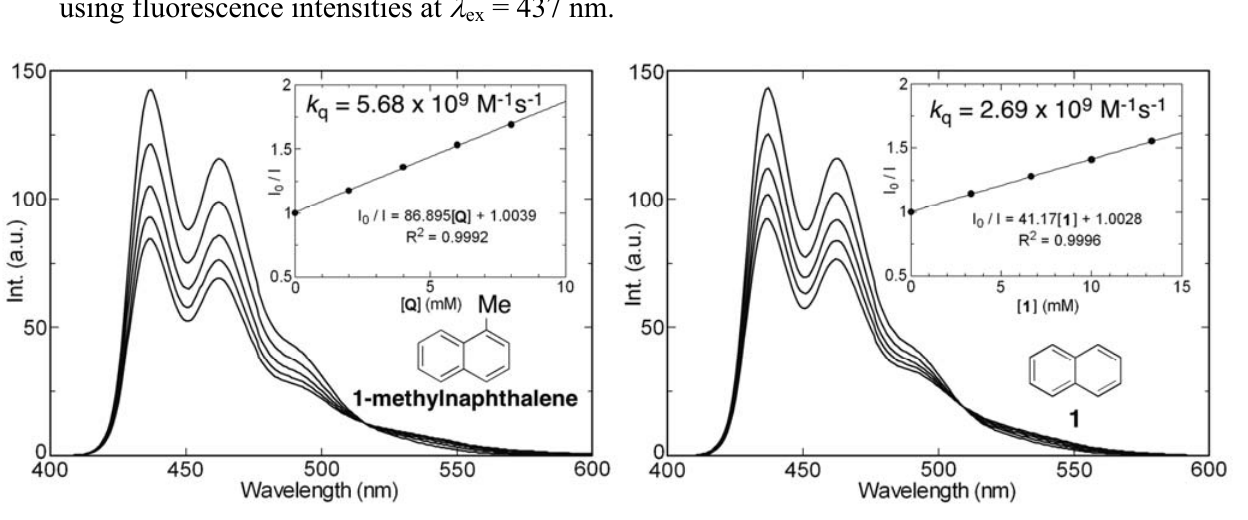
Figure 10. Quenching of the fluorescence of 9,10-dicyanoanthracene (aerated benzene, = 426 nm) by naphthalene derivatives. Insets are Stern-Volmer plots determined by  ex using fluorescence intensities at  = 437 ex